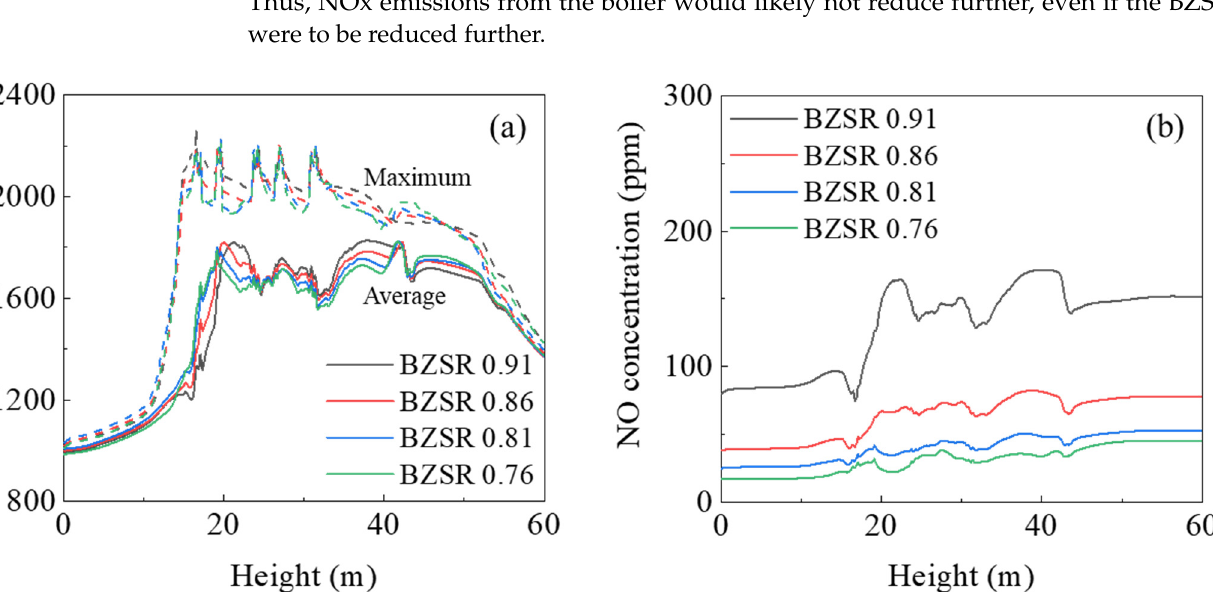
Figure 8. Changes in heat absorption by conversion to methane.